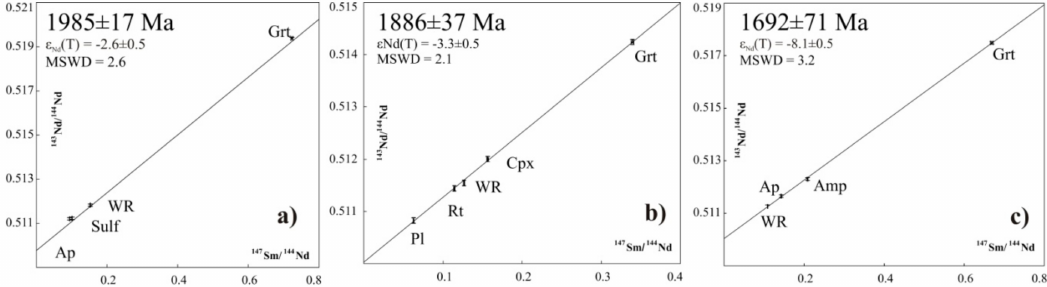
Figure 8. Isotope Sm–Nd isochrones for metamorphic minerals from metagabbroids of the Kolvitsa massif (sample 200) ( a ), rock-forming and metamorphic minerals from anorthosites (sample 225 / 1) ( b ), and gabbro (sample 183) ( c ) of the Kandalaksha massif.